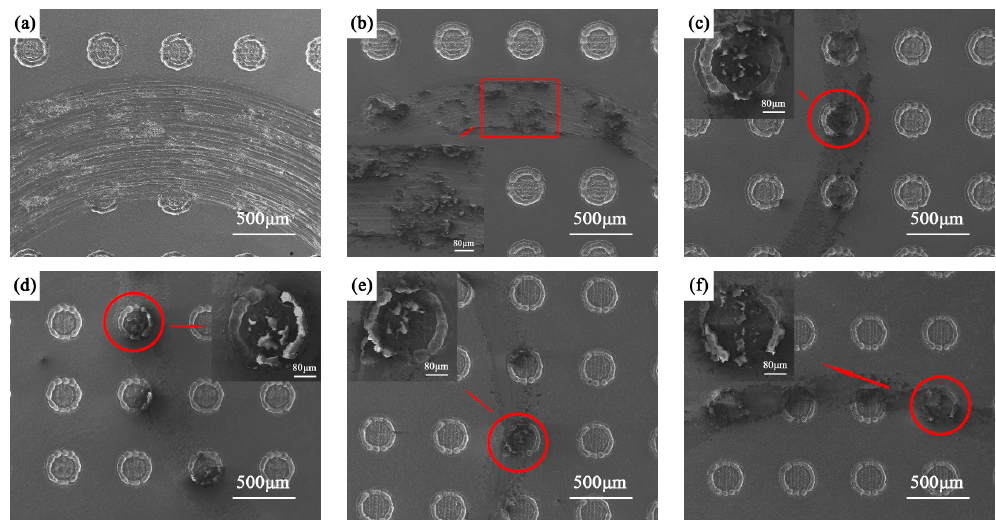
Figure 9. Wear morphologies of titanium alloys after duplex treatment at different temperatures. ( a ) Polished + T, ( b ) 750N + T, ( c ) 800N + T, ( d ) 850N + T, ( e ) 900N + T, and ( f ) 950N +